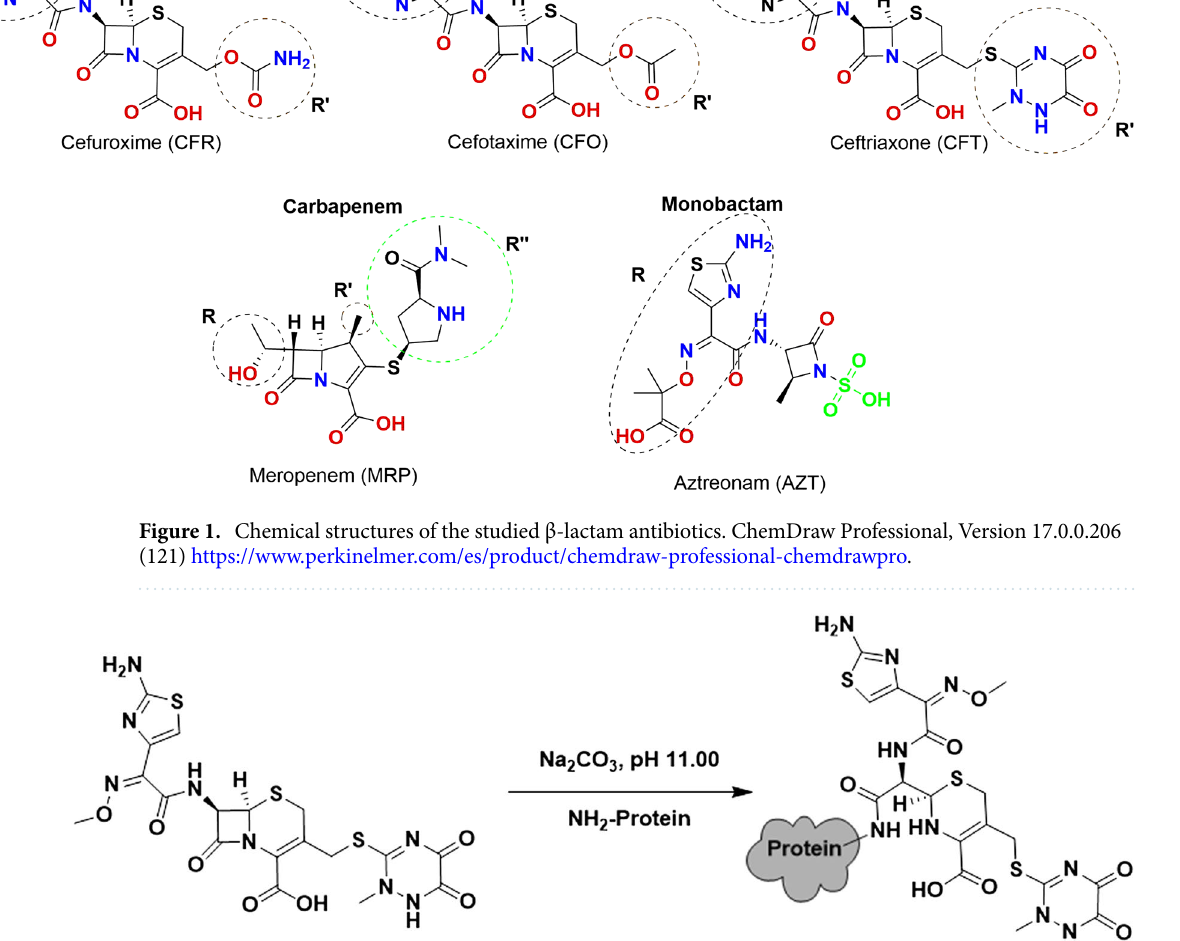
cephalosporin, MRP and AZT. Two carrier proteins, HSA and H1, were employed to produce the antigens. The preparation was as follows: The β-lactam-lloyl determinants were linked through the lysine residues of the carrier proteins by β-lactam ring opening, through the amidation between the carbonyl carbon of the β-lactam ring and the amino group tein (2.0 mg) dissolved in potassium carbonate 0.5 M, pH 11.0, was reacted with the corresponding BLC salt (22–30 μmol depending on the used protein) overnight at room temperature.